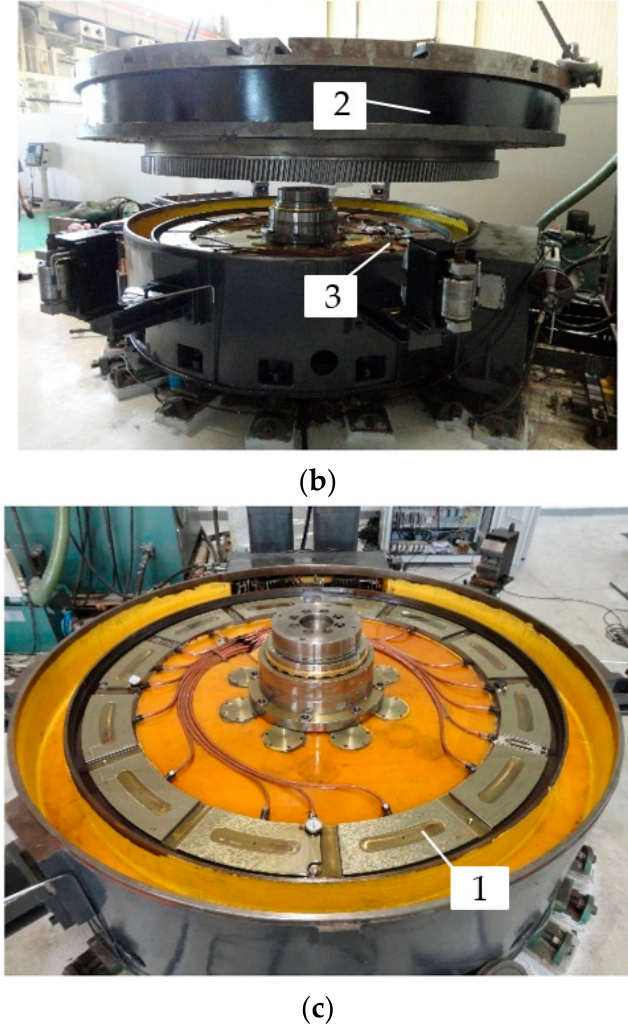
Figure 2. Schematic diagram of load and overturning moment of turntable under partial load. ( a ) Guide rail and parameter schematic; ( b ) Overall physical picture of the turntable; ( c ) Guides and their internal structure. 1 — Oil chamber; 2 — Turntable; 3 — Guide.